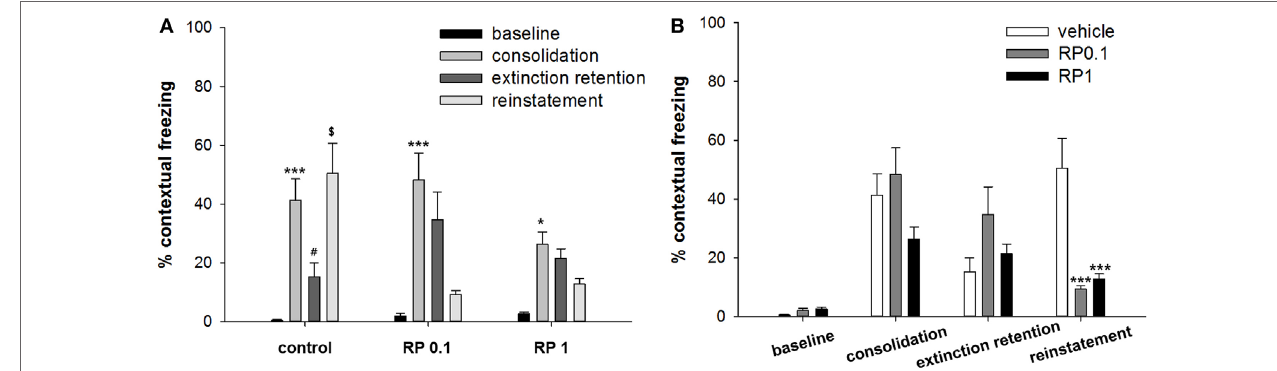
FigUre 2 | The effect of Radix Polygalae (RP) on contextual fear memory consolidation, extinction, and reinstatement. Repeat measure analysis of variance (ANOVA) showed within-group (procedure) effect [ F (1.2, 33.1) = 87.0, p < 0.001, η 2 = 0.763], between-group (treatment) effect [ F (2,27) = 4.3, p = 0.023, η 2 = 0.244], and within–between group interaction [ F (2.5, 33.1) = 4.95, p = 0.009, η 2 = 0.268]. (a) Within-group comparison of % freezing. In control group, fear memory was acquired (basal vs. consolidation, p < 0.001), extinct (consolidation vs. extinction, p = 0.024), and reinstated (extinction vs. reinstatement, p = 0.011). In RP0.1 group, fear memory was acquired ( p < 0.001) but not extinct ( p = 0.66) nor reinstated ( p = 0.11). In RP1 group, fear memory was acquired ( p = 0.011) but not extinct ( p = 0.99) nor reinstated ( p = 0.9). * p < 0.05, *** p < 0.001 vs. baseline. # p < 0.05 vs. consolidation. $ p < 0.05 vs. extinction. (B) Between-group comparison of% freezing. There were no statistical difference among groups in the baseline, consolidated, and extinct level of contextual freezing, but freezing by the reinstatement of fear memory was lower in both RP0.1 (control vs. RP0.1, p < 0.001) and RP1 (control vs. RP1, p < 0.001). *** p < 0.001 vs. control. Data represent mean ± SEM. control: DW; RP0.1: Radix Polygalae 0.1 mg/kg p.o. 18 days; RP1: Radix Polygalae 1 mg/kg p.o. 18